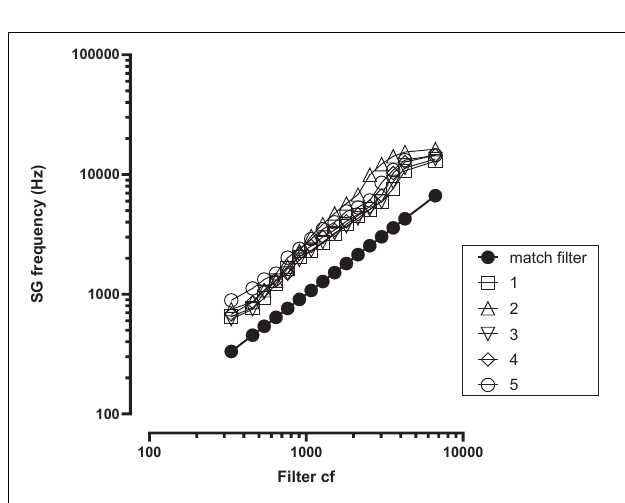
FIGURE 2 | Spiral ganglion (SG) frequency at each electrode for each patient. The solid black function (match filter) indicates the SG frequency matched to the filter cf. SG = spiral ganglion; cf = center frequency; numbers in legend = patient